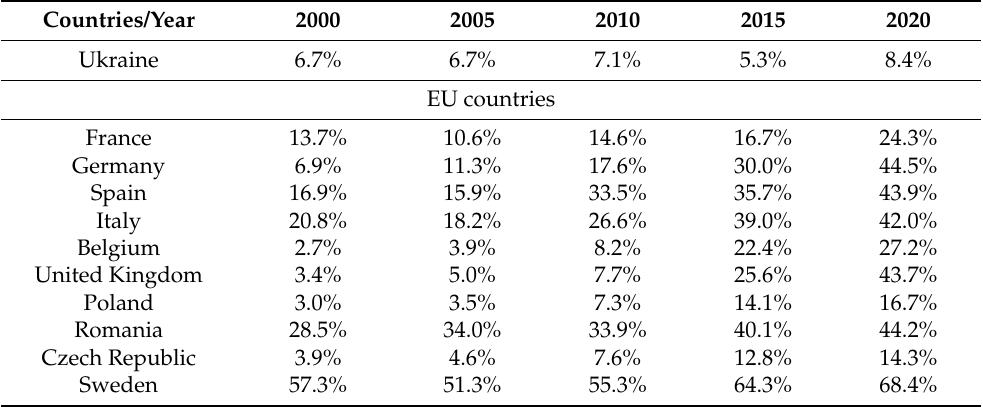
Table 1. The share of renewable energy sources in electricity production in the Ukraine and in the EU countries 2000–2020 [22].